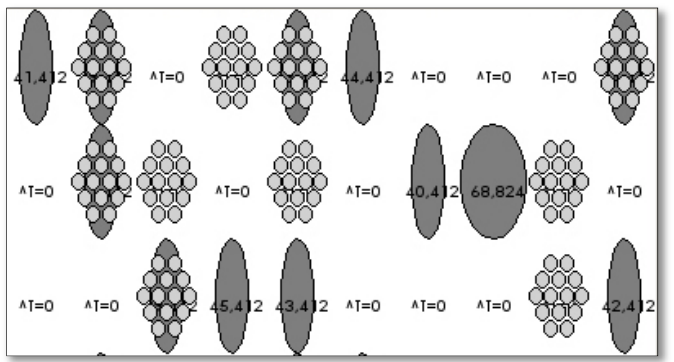
Figure 12. Typical representation of the facade on the abstract model/interface.